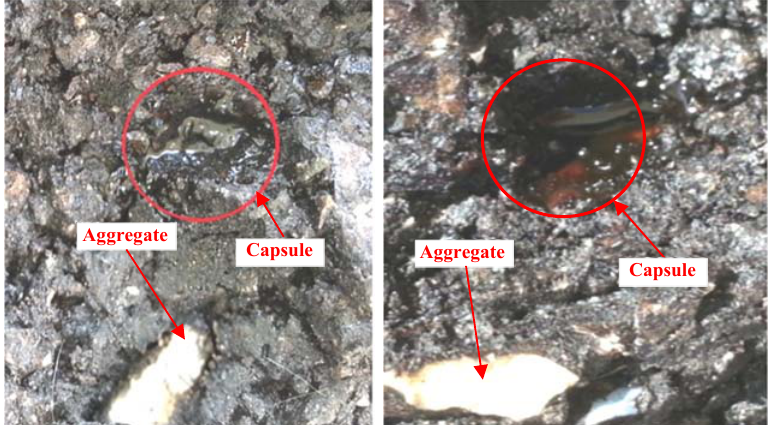
Figure 6: Capsules with thickness from 3 to 4 mm embedded in asphalt mixture. a) Capsule resisted the mixing process; b) Capsule broke under the stress by condensation.